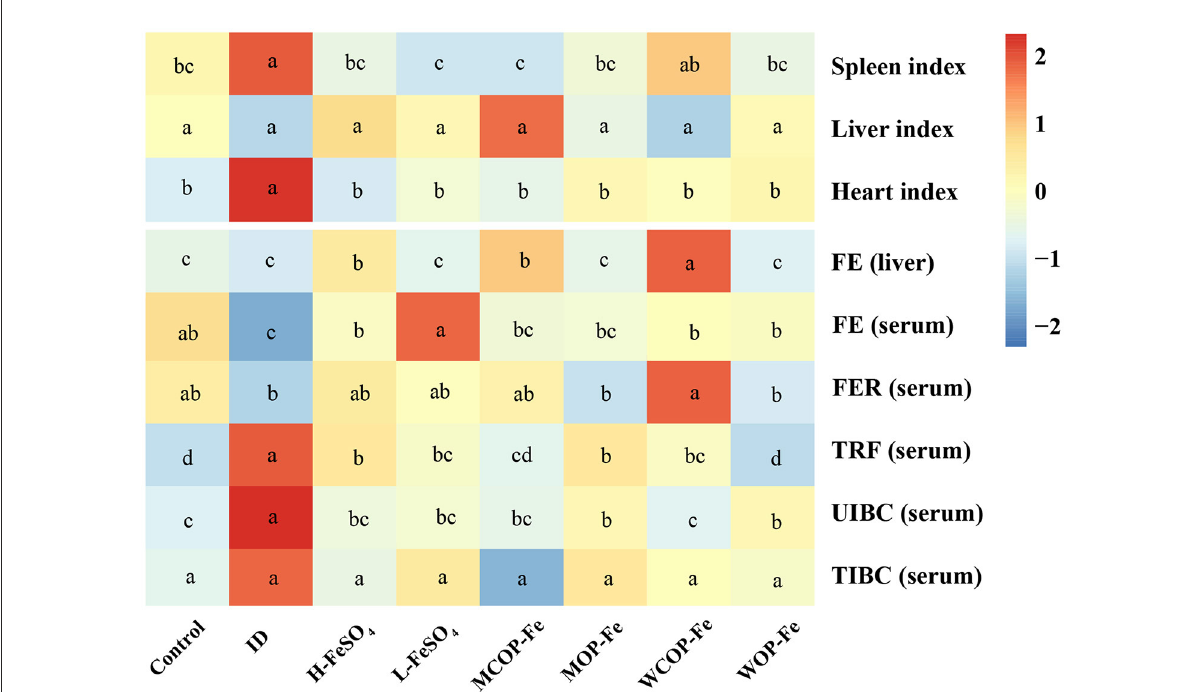
FIGURE3 The organ index and iron related indexes of IDA pregnant rats after iron supplement treatment. The heatmap shows the relative content of the organ index and iron related indexes after normalization. The change in the intensity is marked by different colors, from blue to red as intensity enhancement. Values marked with different letters show significant differences. FE, Liver and serum iron; FER, serum ferritin; TRF, serum transferrin; UIBC, unsaturated iron binding ability; TIBC, total iron binding force; ID, iron deficiency anemia model group (4 ppm FeSO 4 ); H-FeSO 4 , 400 ppm FeSO 4 ; L-FeSO 4 , 40 ppm FeSO 4 ; MCOP-Fe, 400 ppm marine fish oligopeptide iron complex; MOP-Fe, 40 ppm marine fish oligopeptide iron complex; WCOP-Fe, 400 ppm whey protein oligopeptide iron complex; WOP-Fe, 40 ppm whey protein oligopeptide